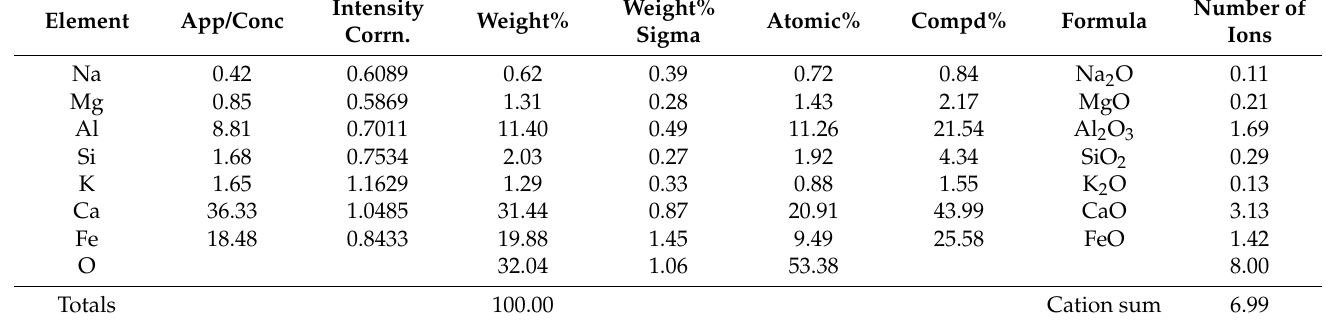
Figure 16. Analysis of amorphous phase of point “ Spectrum 1 ” of Figure 15. Table 8. EDS analysis of amorphous phase of point “Spectrum 1” of Figure 15.